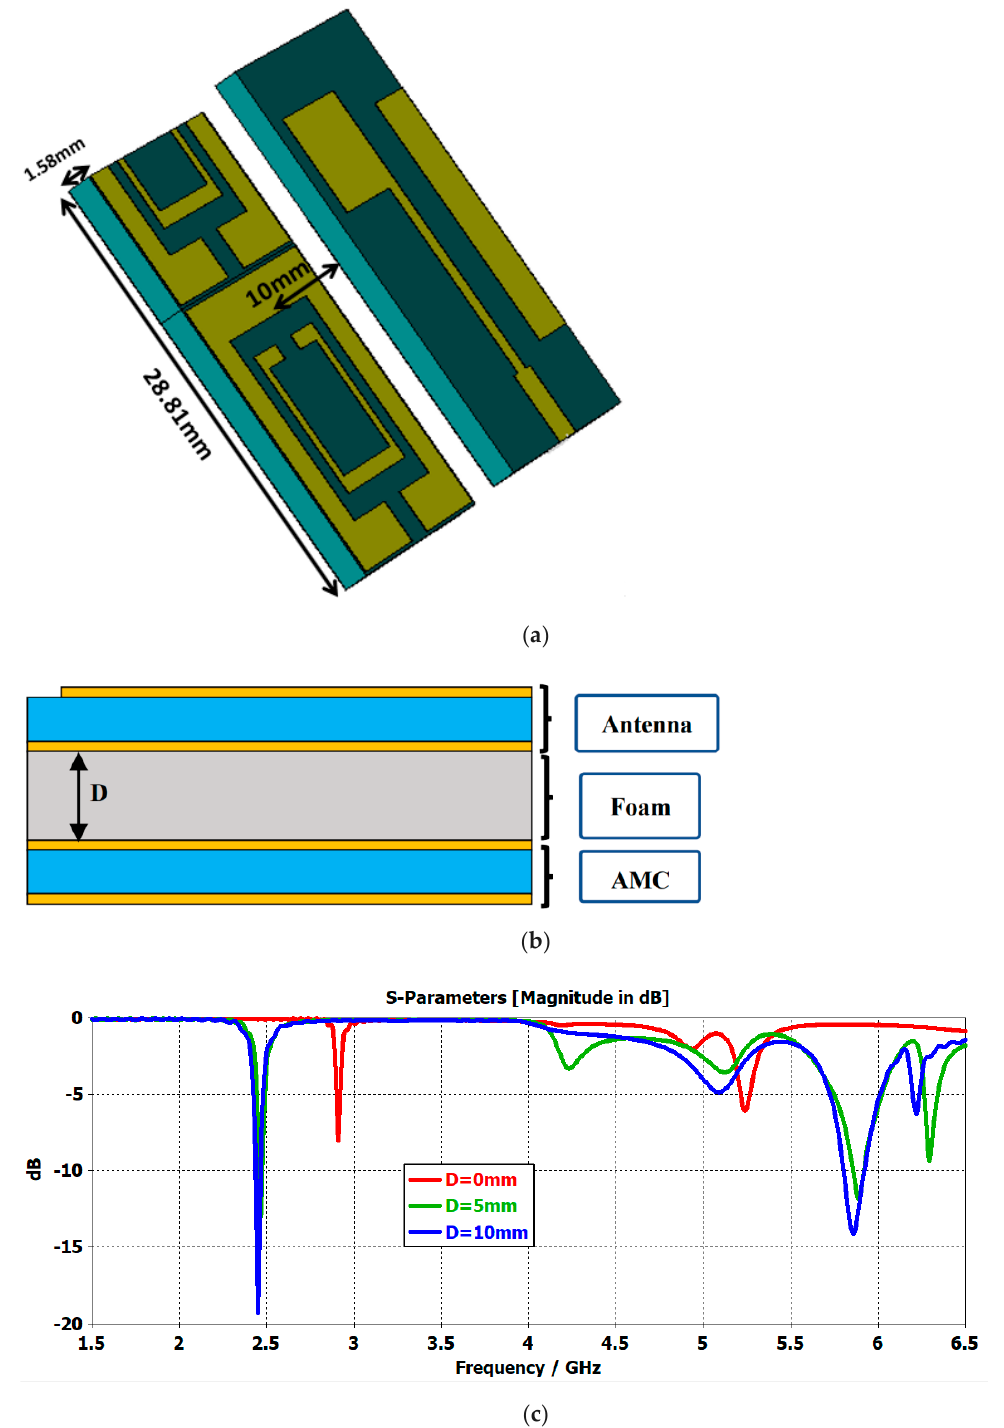
Figure 16. Designed antenna with an AMC at the back: ( a ) antenna with the AMC; ( b ) foam covering cap between the AMC and the antenna; ( c ) S 11 at different distances from the AMC.